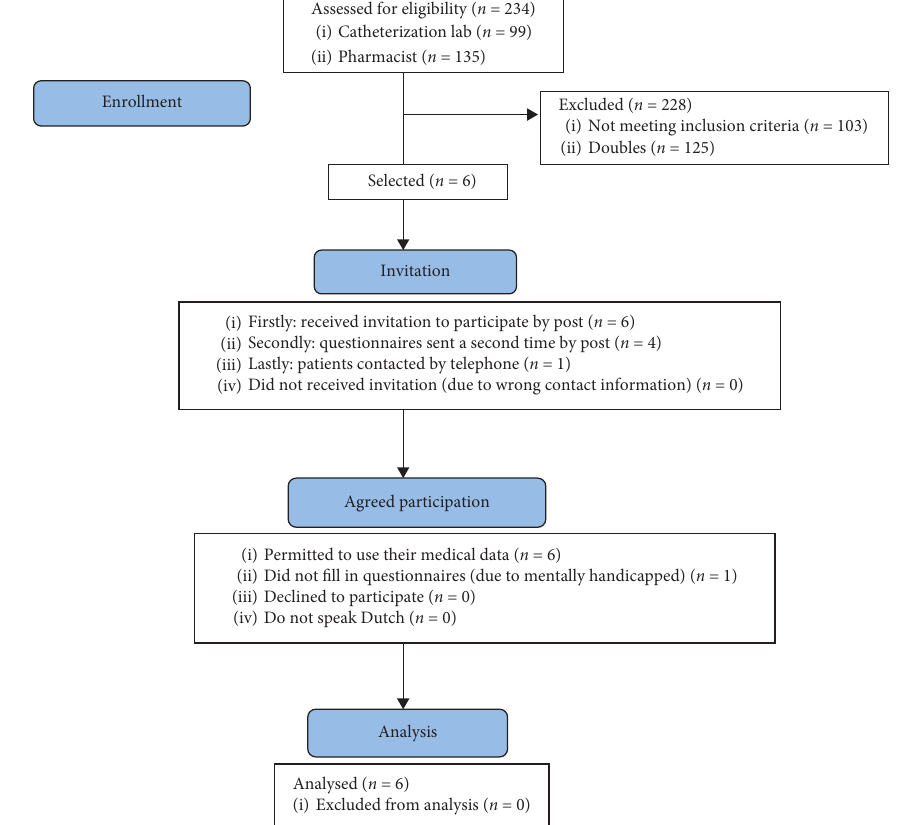
Figure 1: Consort diagram UZGent.